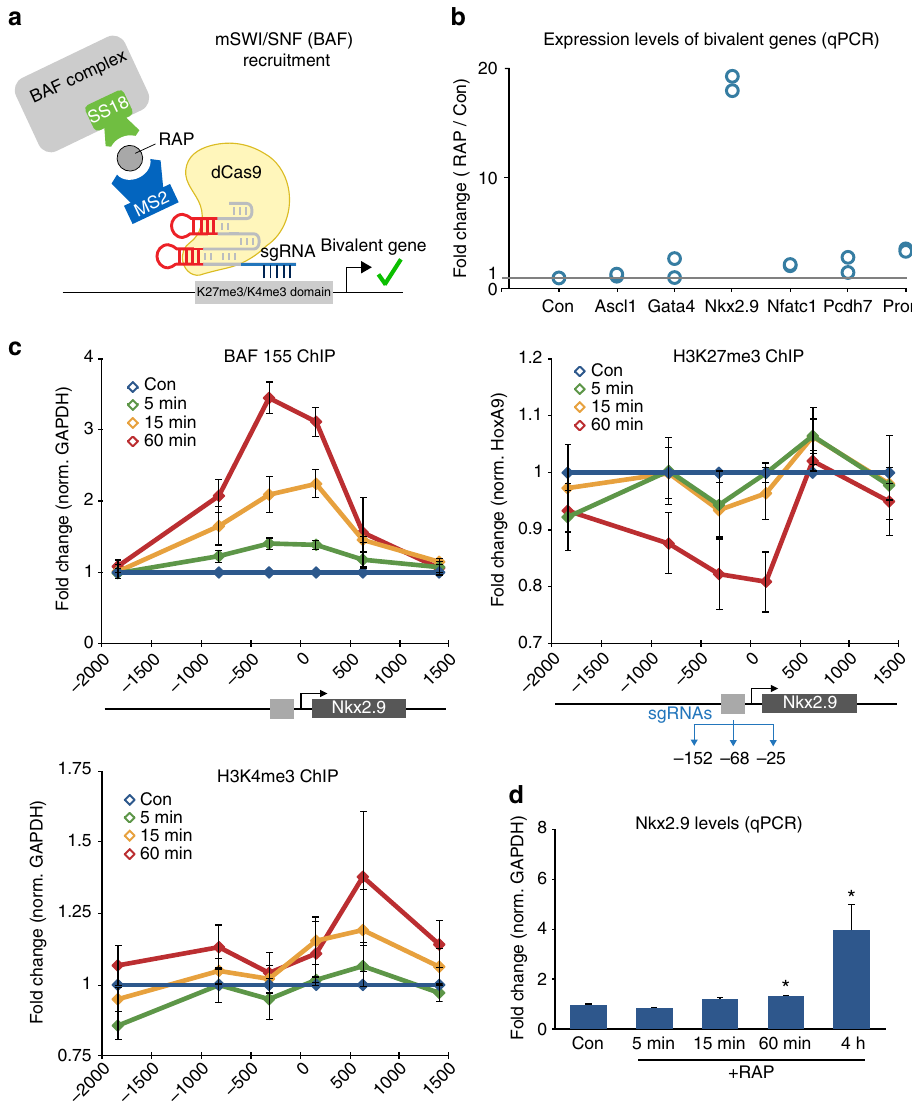
Fig. 3 Rapid BAF complex recruitment to the bivalent Nkx2.9 locus activates transcription in mESCs. a Schematic representation of rapid BAF complex recruitment to bivalent loci in mESCs with SS18-Frb. b Using speci fi c MS2-sgRNAs we targeted the BAF complex to 6 different bivalent loci in mESC lines. After 48 h RAP treatment, we detected a 2-fold to 3-fold increase in Gata4 , Nfatc1 , Pcdh7 , and Prom1 gene expression levels, as well as a 20-fold increase in Nkx2.9 expression by qPCR. n = 2 per condition c Rapid BAF recruitment studies by RAP treatment performed over minutes at the Nkx2.9 locus. BAF155 ChIP shows enrichment for this subunit of the complex after 5 min of SS18-Frb recruitment. ChIP experiments show loss of H3K27me3 over the bivalent recruitment site after 60 min RAP treatment, whereas H3K4me3 levels increase over the gene body. n = 3; error bars s.e.m. d Nkx2.9 expression levels measured by qPCR during the time course of BAF recruitment. n = 4; error bars s.e.m. p <